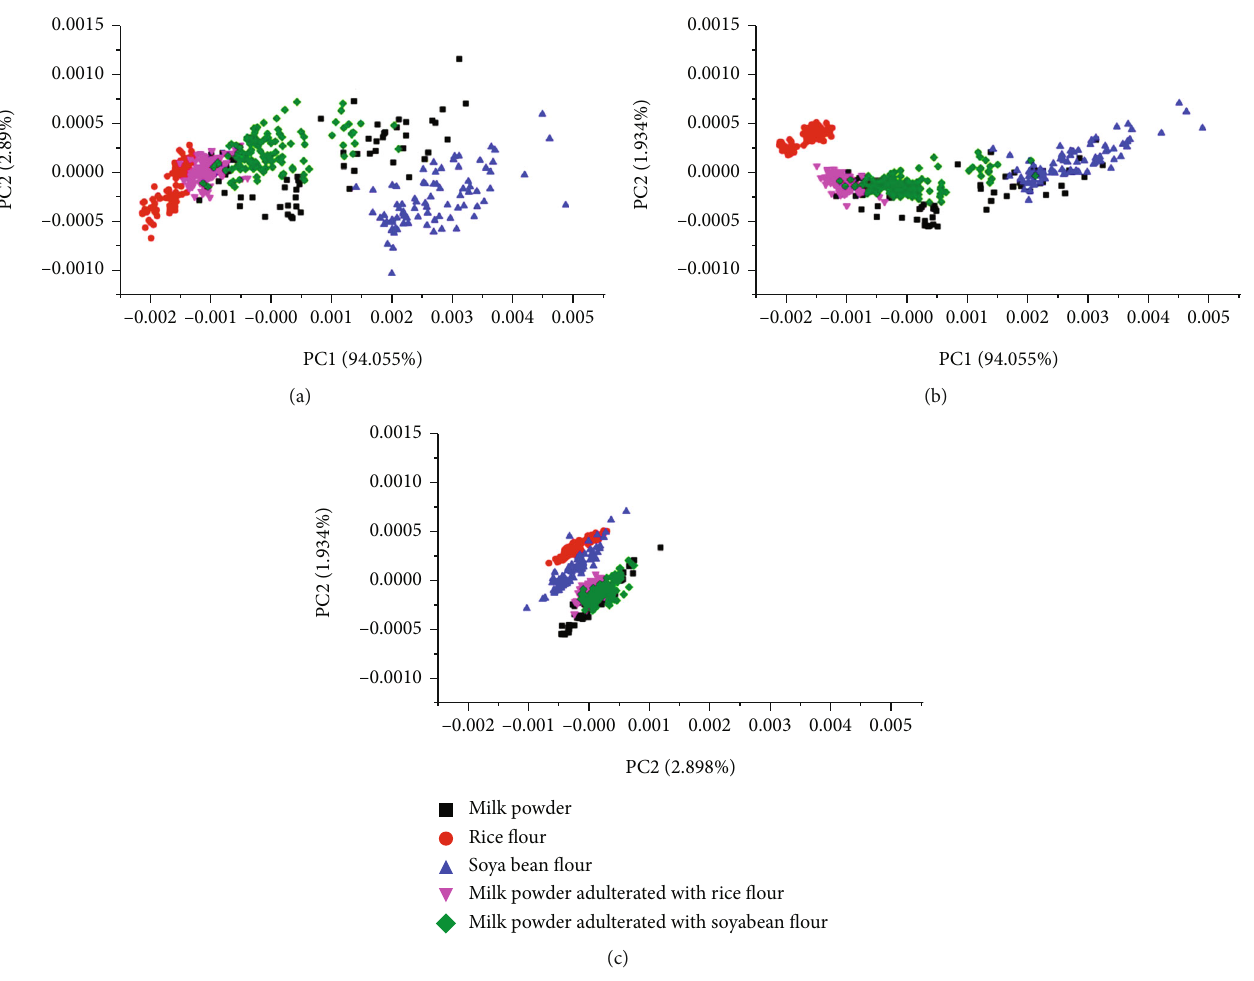
Figure 1: PCA score plot for classi fi cation of milk powder and adulterated milk powder with soybean fl our and rice fl our using PC1 vs. PC2 (a), PC1 vs. PC3 (b), and PC2 vs. PC3 (c)